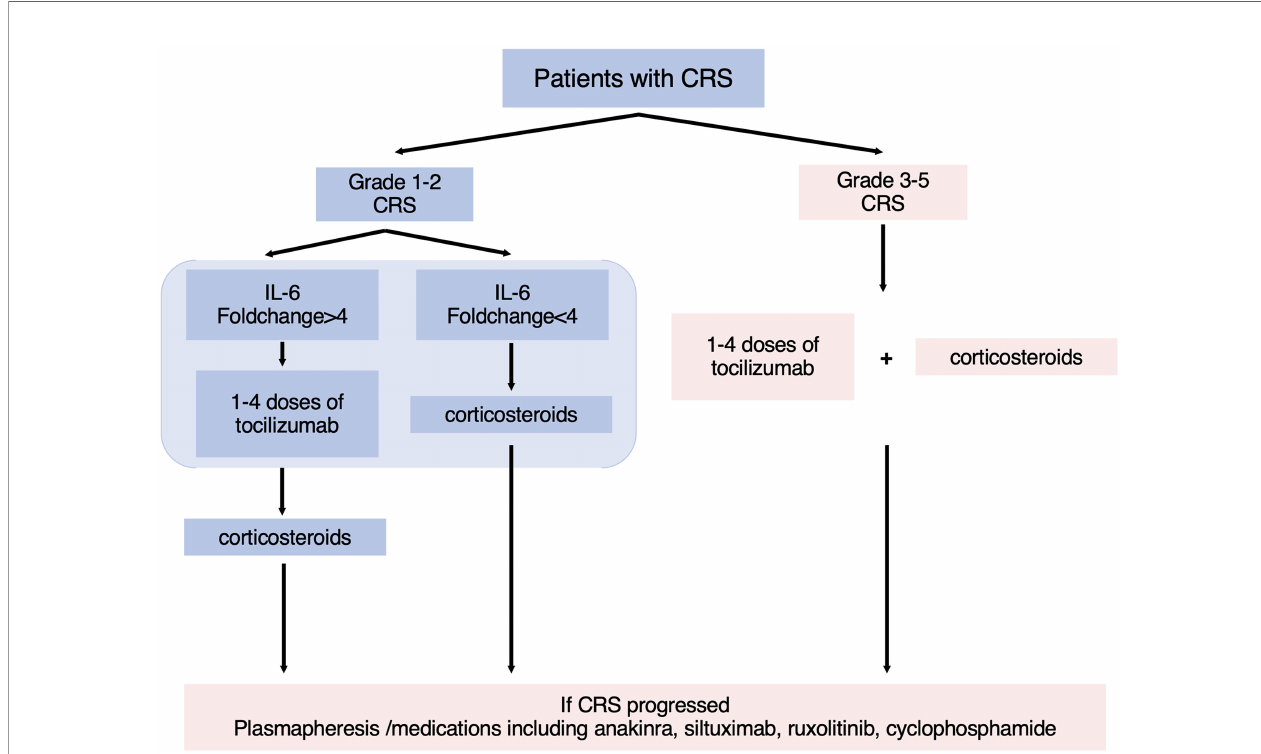
FIGURE 5 | The fl owchart of guidelines for the treatment of CRS. According to the ASTCT grading system and level of IL-6, patients were recommended for different treatment